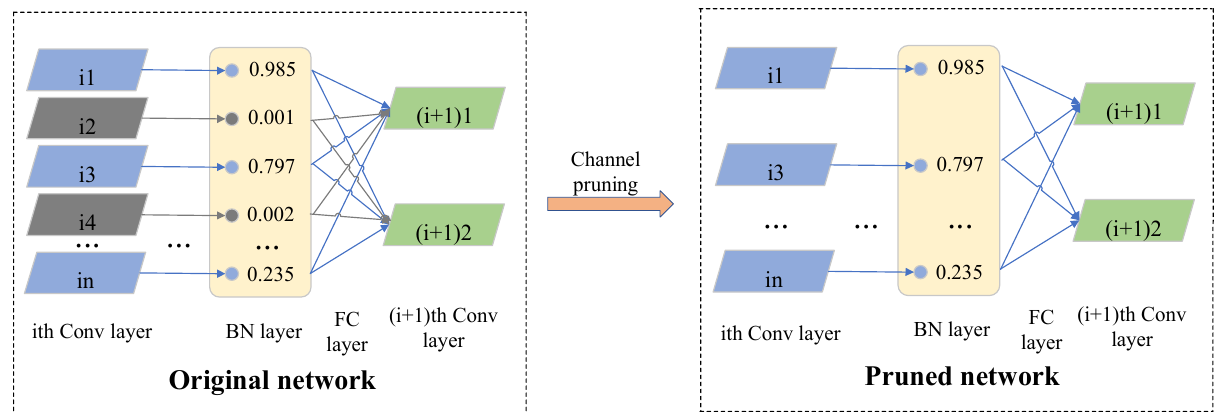
Figure 6. The diagram for model pruning.